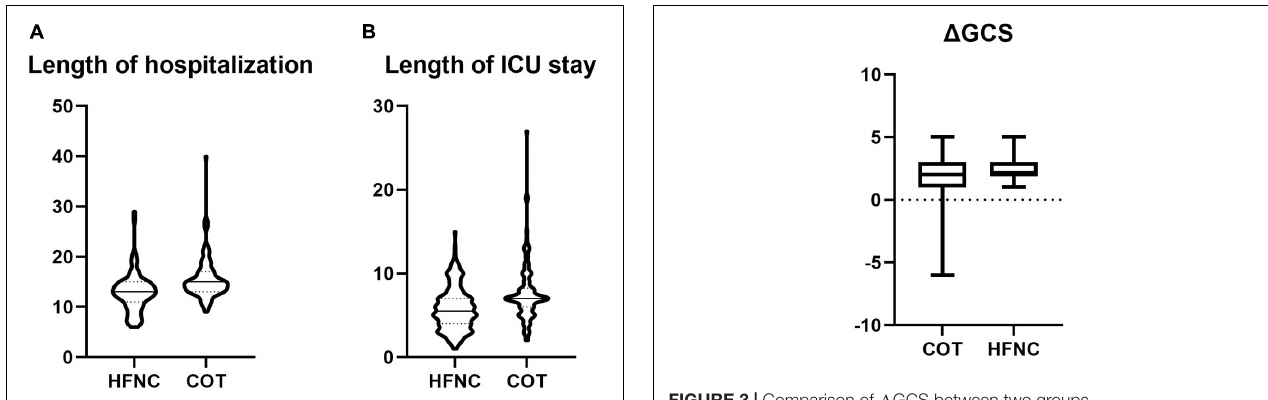
FIGURE 2 | (A) Comparison of length of hospitalization between two groups; (B) comparison of length of ICU stay between two groups (A,B) .